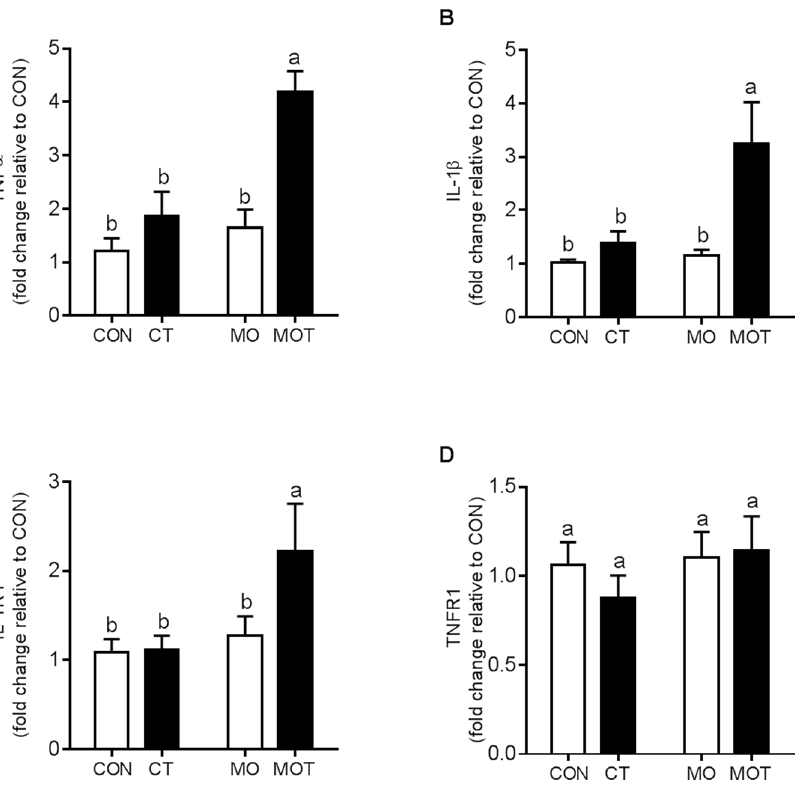
Figure 5. Maternal hepatic inflammatory gene expression. (a) TNF a ; (b) IL-1 b ; (c) IL-1R1; (d) TNFR1. Lower case letter superscripts ( a,b,c ) indicate multiple comparison procedures were conducted for diet and taurine interaction. Groups that do not share the same letter are significantly different from each other (p , 0.05). Data are means 6 SEM, n=7–9 per group.